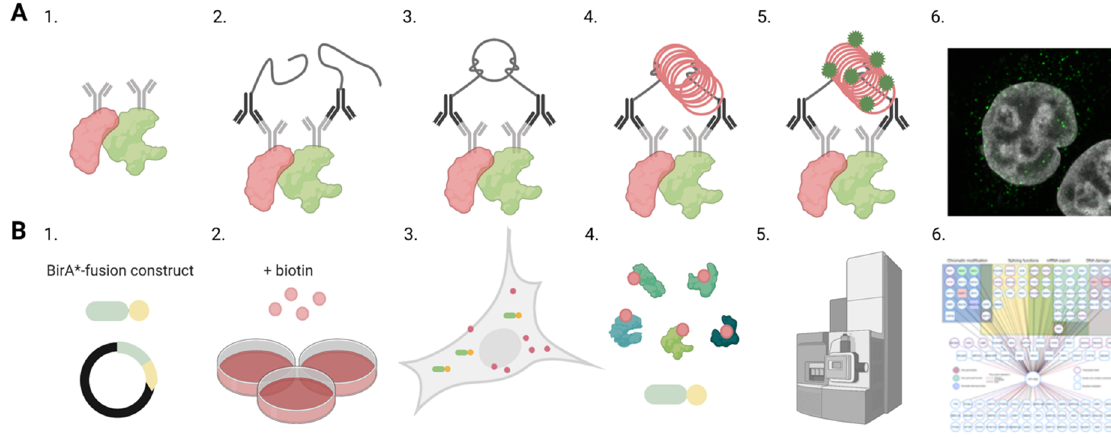
Figure 2. Analyses of protein–protein interactions in infection. Schematic overviews of proximity ligation assay (PLA) and proximity-dependent biotin identification (BioID) methods to identify and localize interactions between viral and host proteins. ( A ) The schematic representation of PLA assay. (1) Primary antibodies are used to target proteins of interest shown in red and green. (2) Secondary antibodies with PLA oligonucleotide probes bind to the primary antibodies. (3) Closely located PLA probes are ligated together, and (4) the formed circular DNA is amplified. (5) The amplified DNA (red) is labelled by fluorescent probes (green). (6) Confocal microscopy image shows the intracellular distribution of the PLA signals (green). Nuclei were stained with DAPI (grey). ( B ) Outlines of the BioID workflow. (1) Transfection of cells with BirA*-viral protein-fusion constructs and the generation of a stable inducible cell line. (2) Addition of biotin to the culture media and viruses if infection is required. (3) Cell culture period during which biotin ligase activity of BirA* fusion protein induces proximity-dependent biotinylation of neighbouring endogenous and viral proteins. (4) Cell lysis and the streptavidin-affinity purification of biotinylated proteins from cell lysates. (5) Mass spectroscopy and analyses of protein associations. (6) Interaction network indicating interaction partners of viral protein and biological processes involved. Images were created with